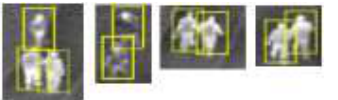
Figure 26. Separation of connected pedestrians.